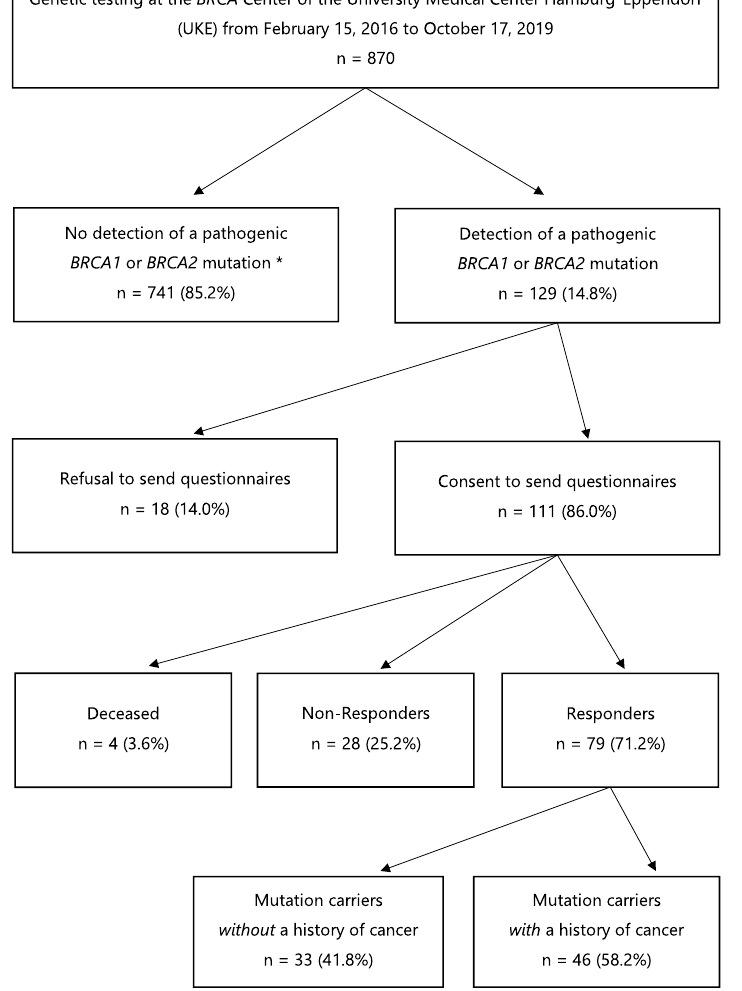
Figure 1. Consort diagram. *Includes tests with inconspicuous results, detection of other mutations, variants of unclear